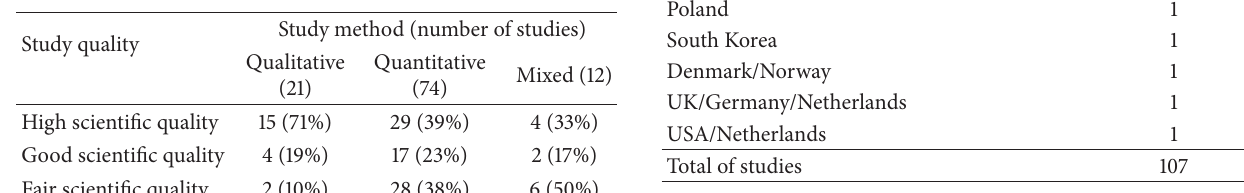
Figure 2: Number of studies published per year between 2000 and June 2010. Table 1: Sample data representation.